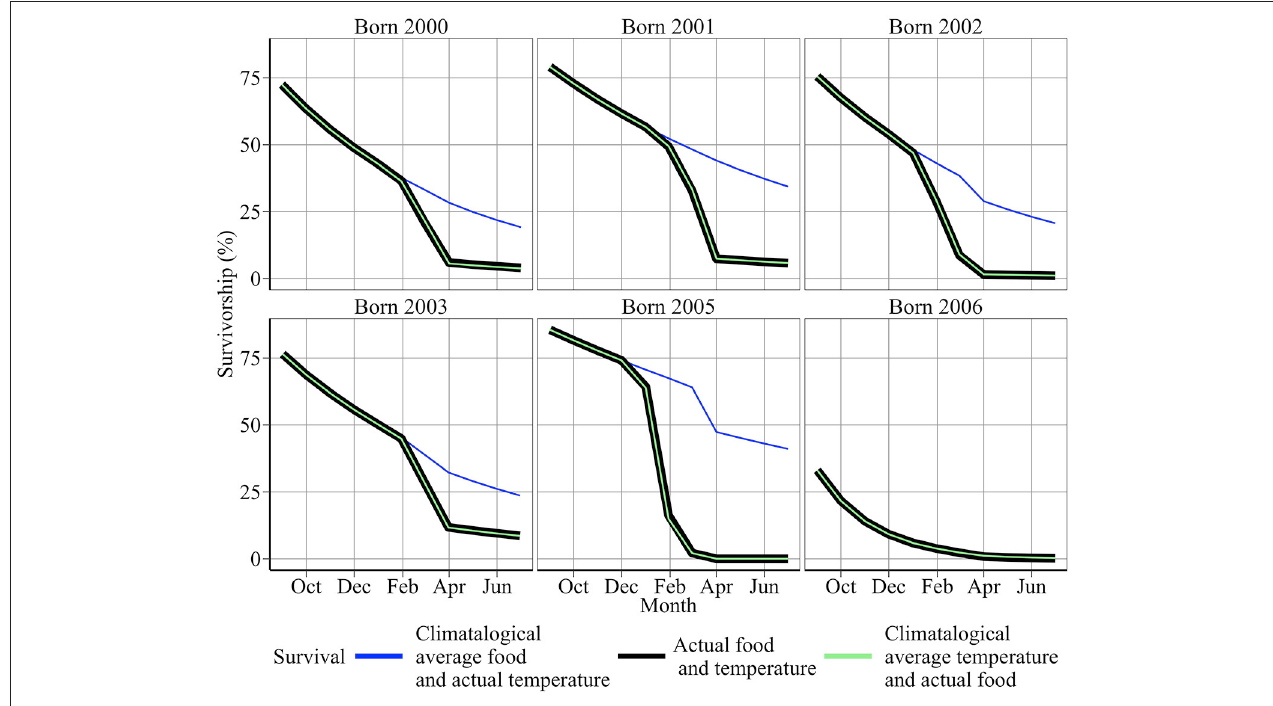
FIGURE 6 | Sensitivity of survival to food and temperature. Red points denote results using the best model fit. Blue and black points denote results using climatological average food and temperature between 2000 and 2008,